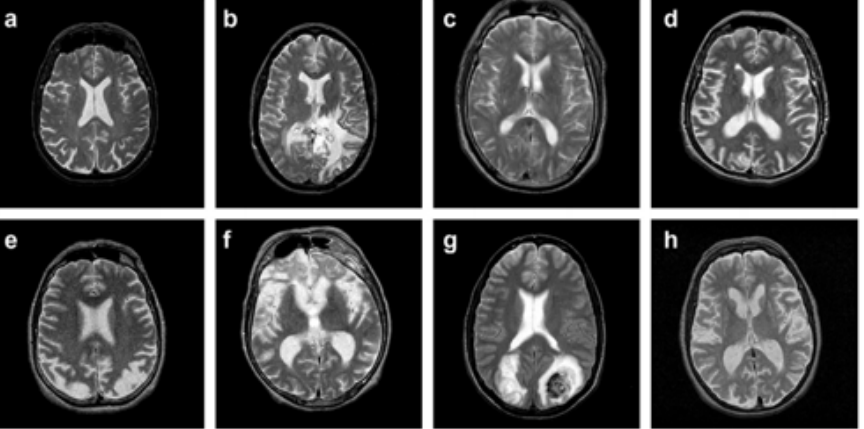
Figure 6. ( a ) normal brain MRI, ( b ) glioma, ( c ) meningioma, ( d ) Alzheimer, ( e ) Alzheimer plus ( f ) visual agnosia pic’s disease, ( g ) sarcoma, and ( h ) Huntington’s.